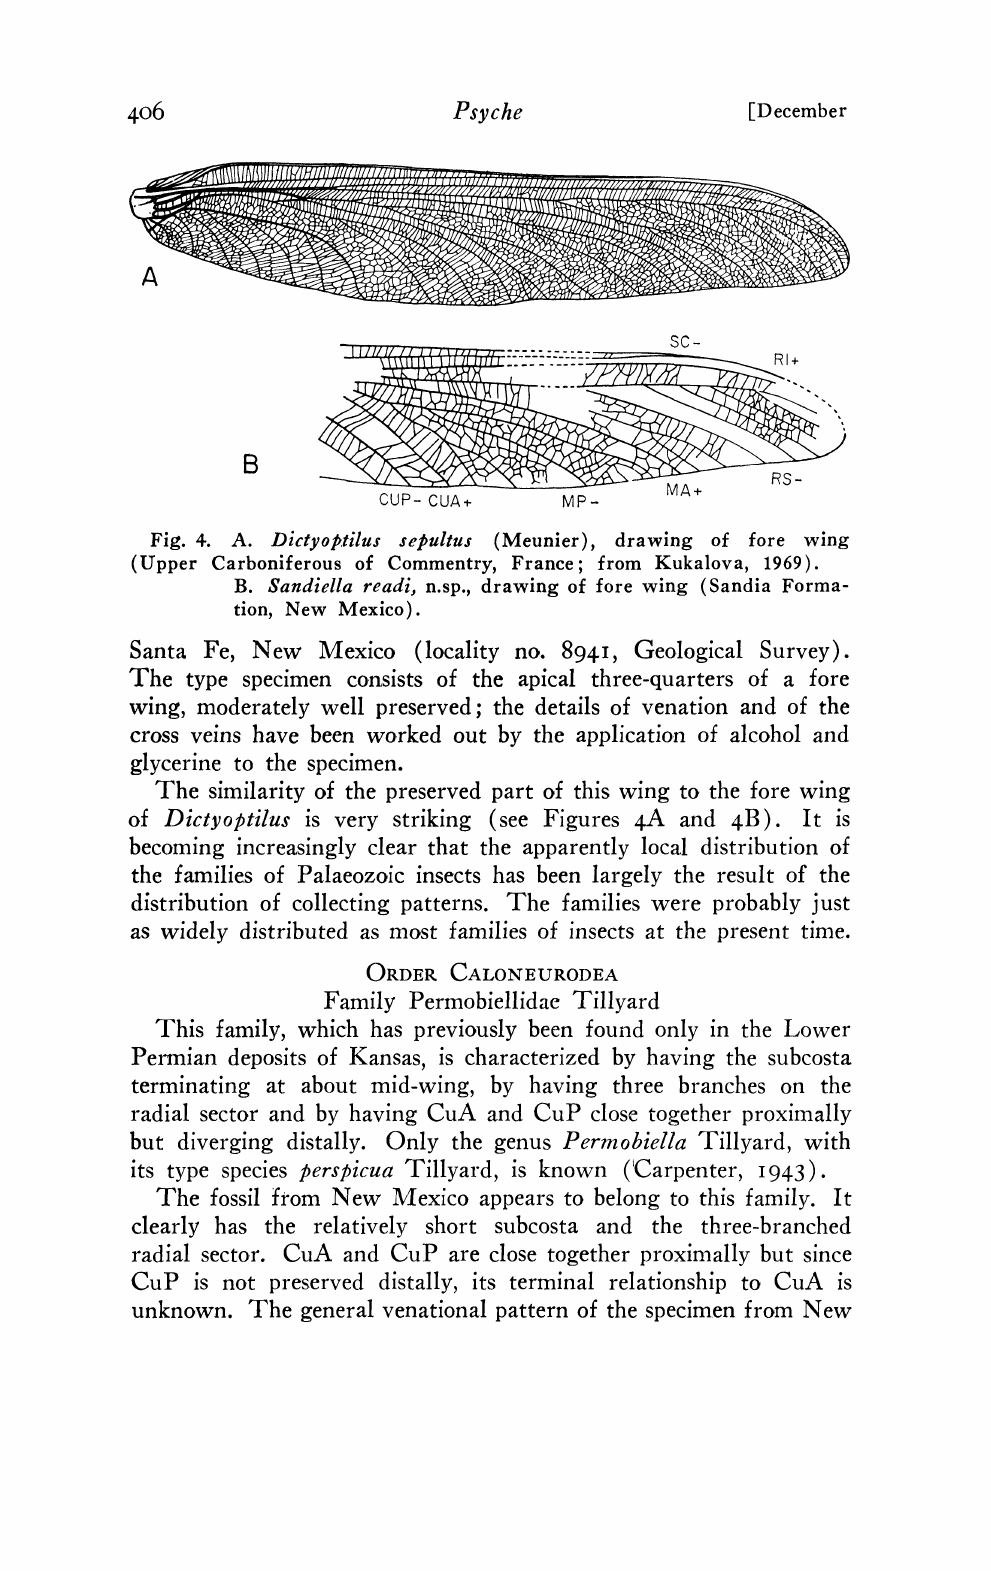
Fig. 4. A. Dictyop:tilus sepultus (Meunier), drawing of fore wing (Upper Carboniferous of Commentry, France; from Kukalova, 1969). B. 8andiella readi, n.sp., drawing of fore wing (Sandia Forma- tion, New